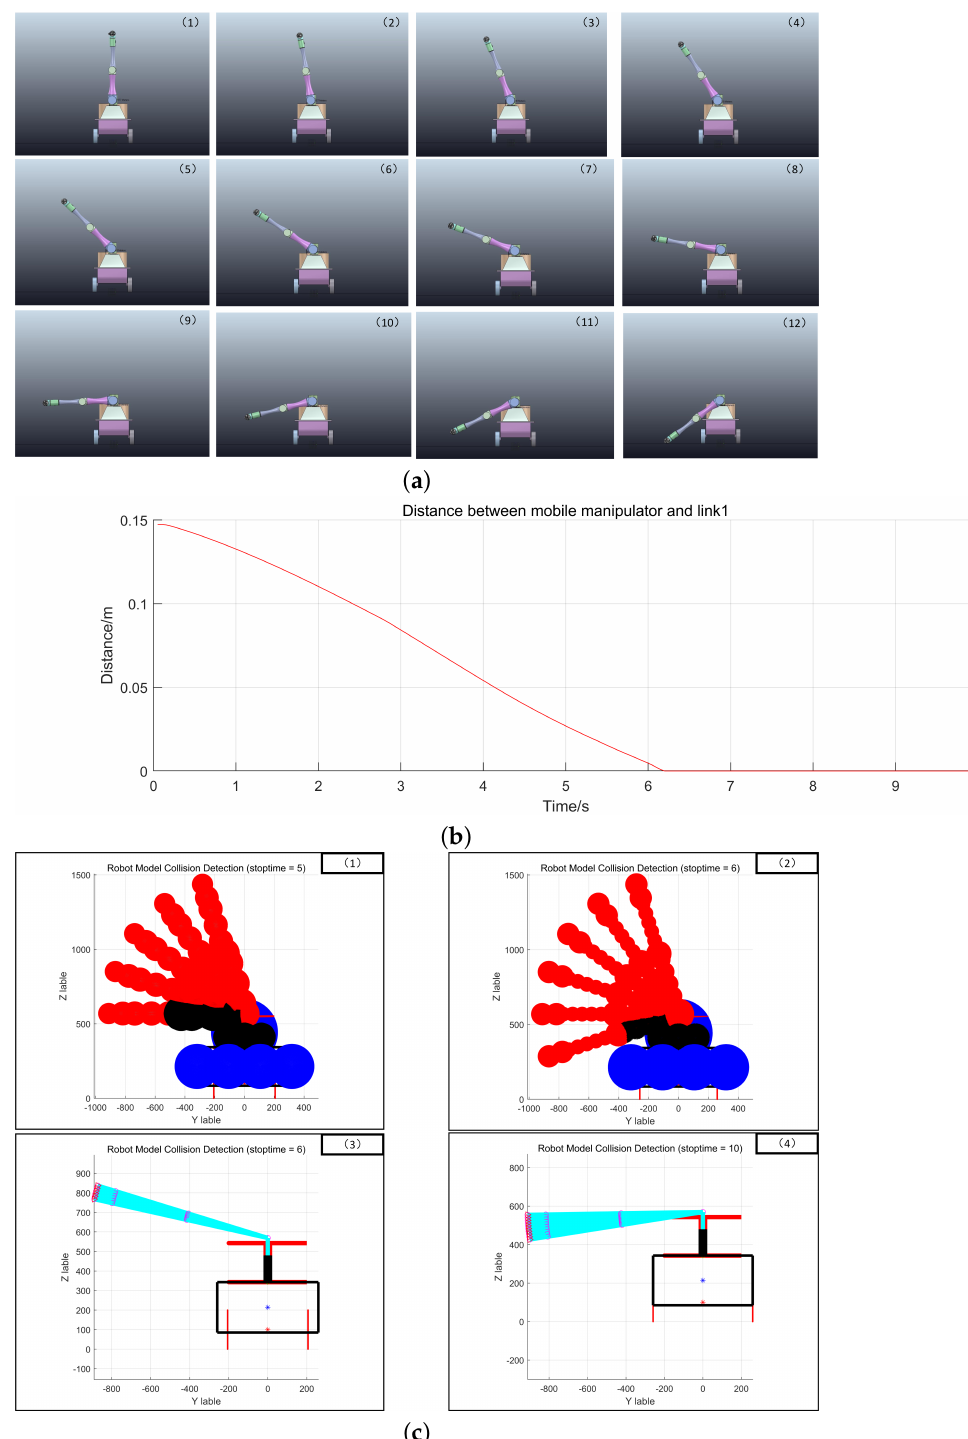
Figure 11. Detection of self-collision between the mobile platform and the manipulator subsystem. ( a ) The movement of the mobile manipulator in situation 3 based on the VREP software; ( a1 – a9 ) The movement of the mobile manipulator before reaching collision location in situation 1 based on the VREP software; ( a10 – a12 ) The movement of the mobile manipulator after reaching collision location in situation 1 based on the VREP software; ( b ) Distance changes between two components of the manipulator subsystem; ( c1 ) Detection of self-collision using the typical method; ( c2 ) Detection of self-collision using the improved method; ( c3 ) Simplify the detection of self-collision using the typical method; ( c4 ) Simplify the detection of self-collision using the improved